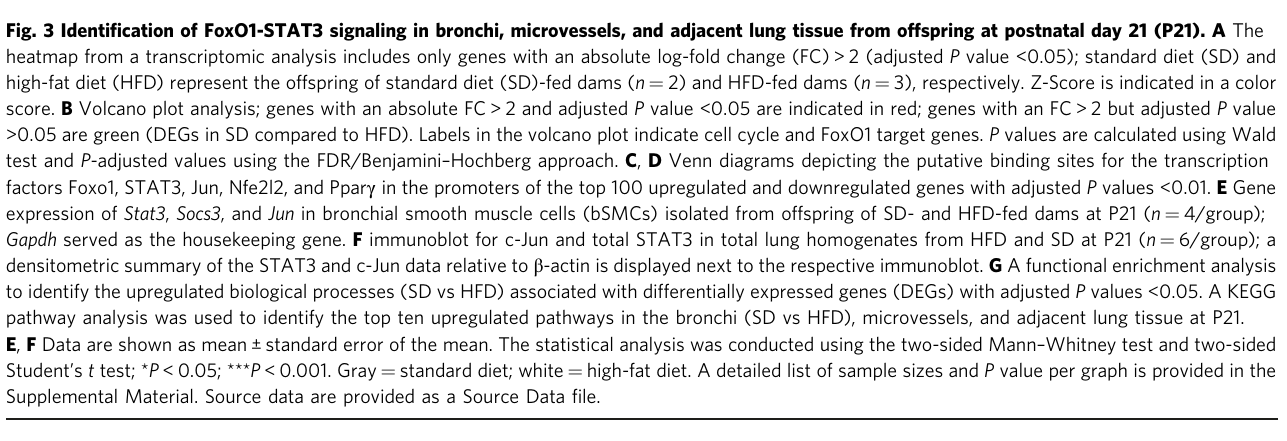
Fig. 3 Identi fi cation of FoxO1-STAT3 signaling in bronchi, microvessels, and adjacent lung tissue from offspring at postnatal day 21 (P21). A The heatmap from a transcriptomic analysis includes only genes with an absolute log-fold change (FC) > 2 (adjusted P value <0.05); standard diet (SD) and high-fat diet (HFD) represent the offspring of standard diet (SD)-fed dams ( n = 2) and HFD-fed dams ( n = 3), respectively. Z-Score is indicated in a color score. B Volcano plot analysis; genes with an absolute FC > 2 and adjusted P value <0.05 are indicated in red; genes with an FC > 2 but adjusted P